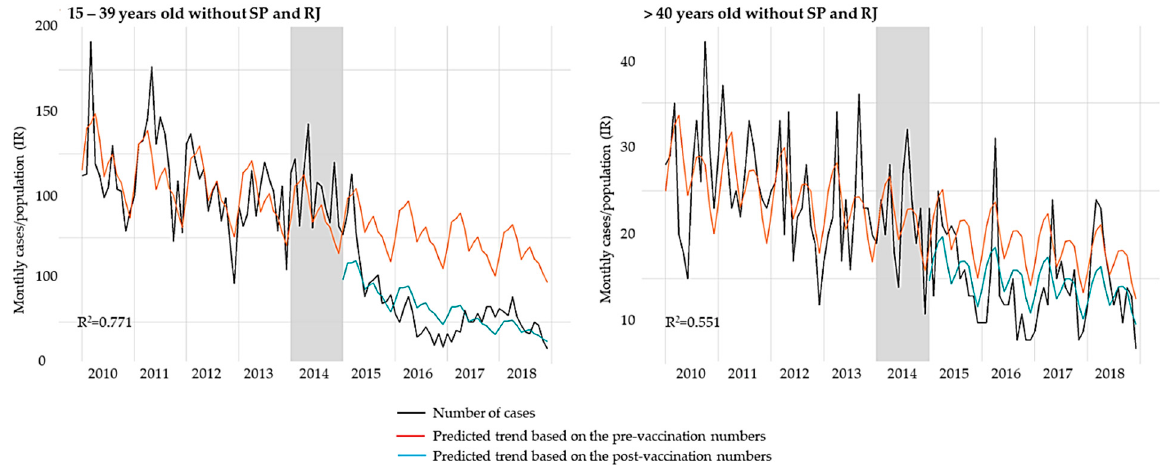
Figure 3. Trends in monthly number of hepatitis A cases over the study period for age groups 15–39 years old and ≥ 40 years old subtracting data from São Paulo and Rio de Janeiro. Grey bars represent the year of hepatitis A vaccine introduction (transition period).